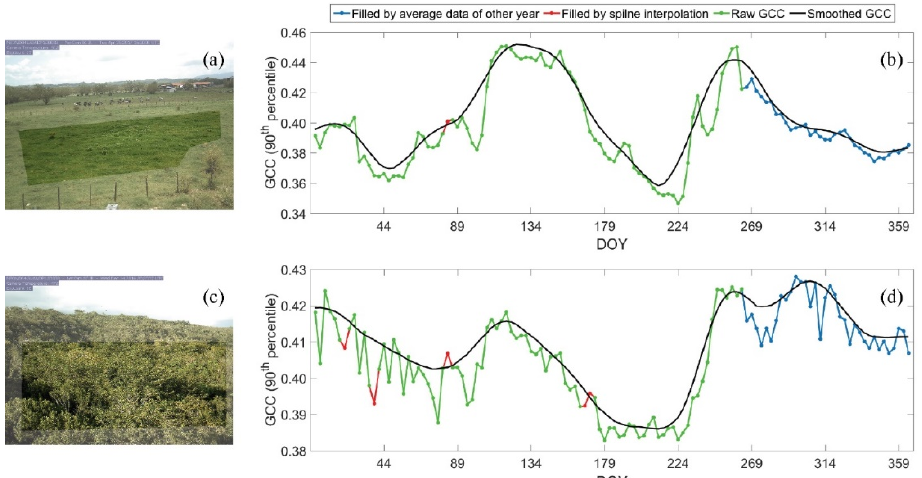
Figure 7. The region of interest (ROI) of photos in PhenoCam site A ( a ) and PhenoCam site B ( c ) and their derived GCC time series in 2017 ( b , d ) in the tropical dry forest zone of Puerto Rico. DOY: day of